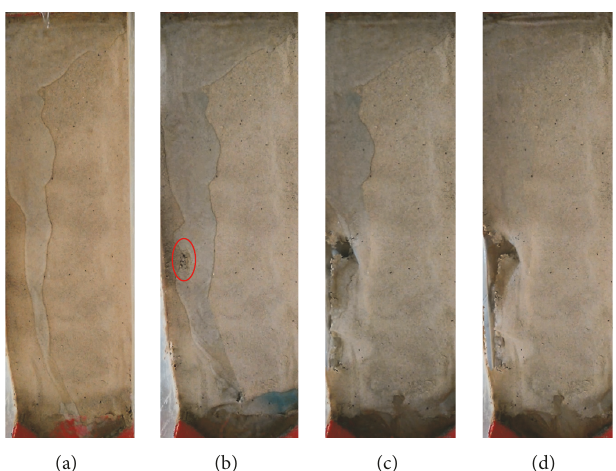
Figure 13: The failure pattern of specimen reinforced with polymer 3%: (a) development stage; (b) failure stage 1; (c) failure stage 2; (d) stable